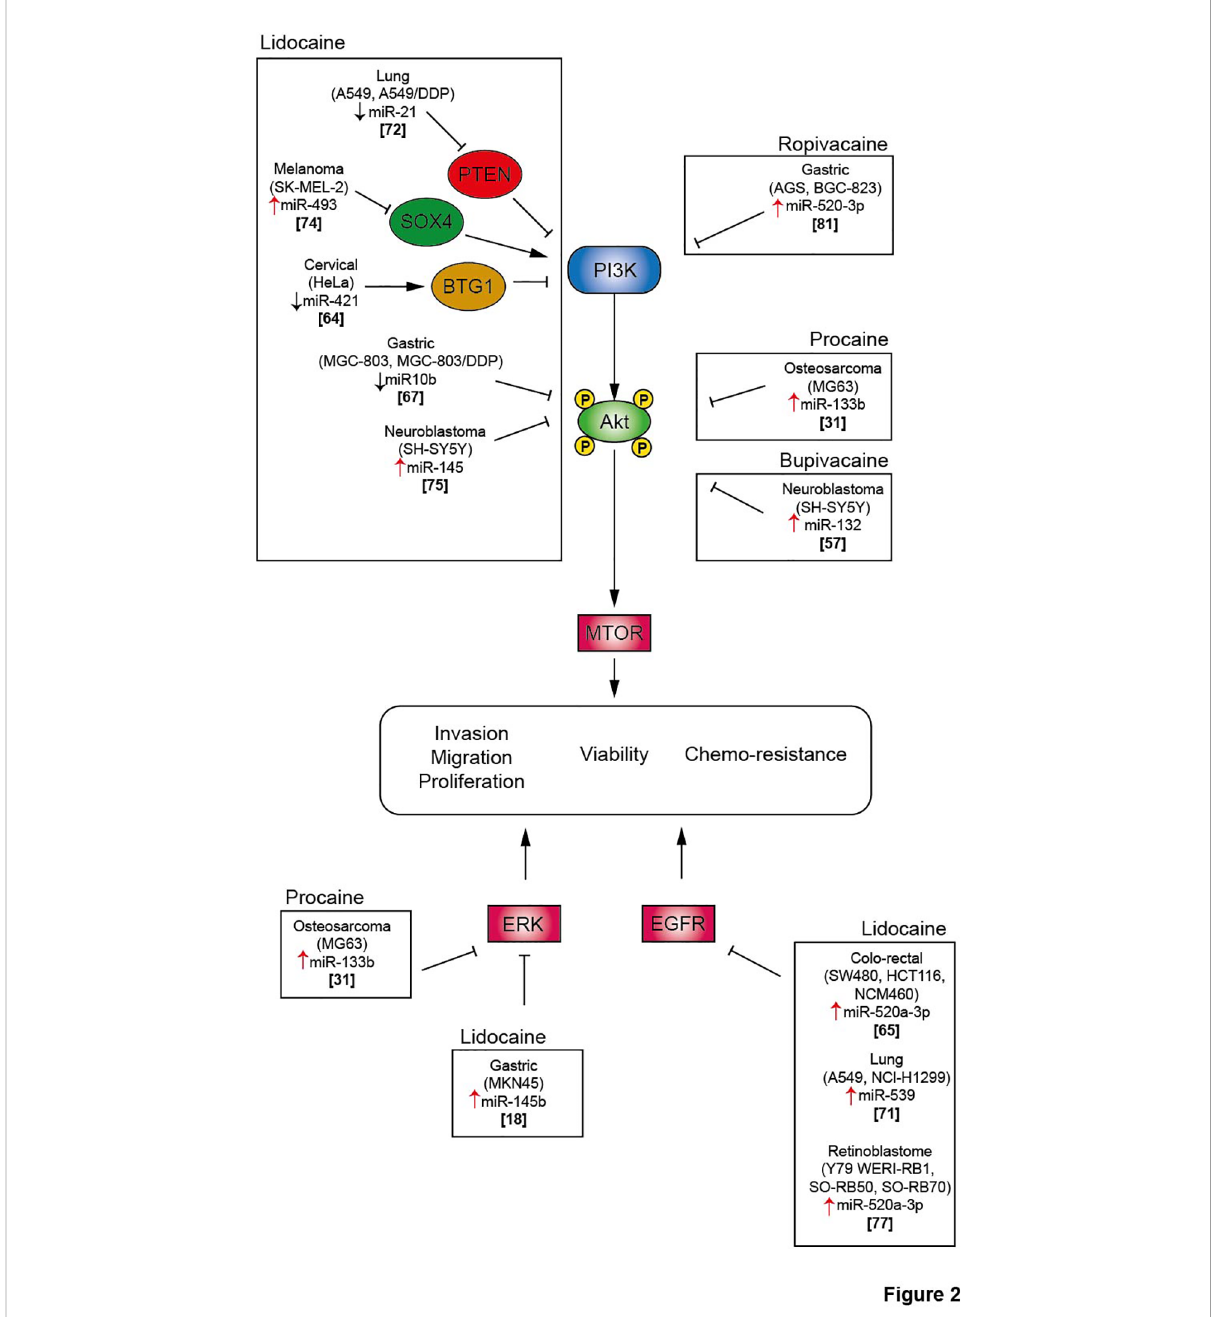
FIGURE 2 Local anesthetics inhibit cell proliferation, migration and invasion and promote cancer cell death via inhibition of several signaling pathway. Akt, protein kinase B; BTG1, B cell translocation gene 1; DDP, cisplatin; EGFR, Epithelial growth factor receptor; ERK, extracellular signal-regulated kinase; mTOR, mammalian Target of Rapamycin; PI3K, phosphoinositide-3 kinase; PTEN, Phosphatase and TENsin homolog; SOX4, SRY-Box Transcription Factor